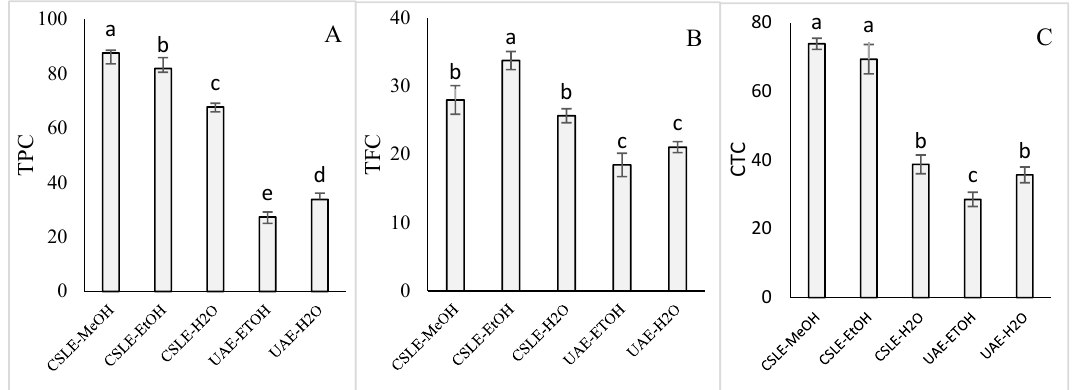
Figure 2. Total phenolic compounds (TPC) (mg/g) ( A ), total flavonoid compounds (TFC) (mg/g) ( B ), and total condensed tannins content (CTC) (mg/g) ( C ) of lentil seed coat extracted by conventional solid-liquid extraction (CSLE) and ultrasound-assisted extraction (UAE) with aqueous methanol (MeOH), aqueous ethanol (EtOH), and water (H 2 O) as extraction solvent. Values with different superscripts within the same graph are significantly different for p < 0.05.